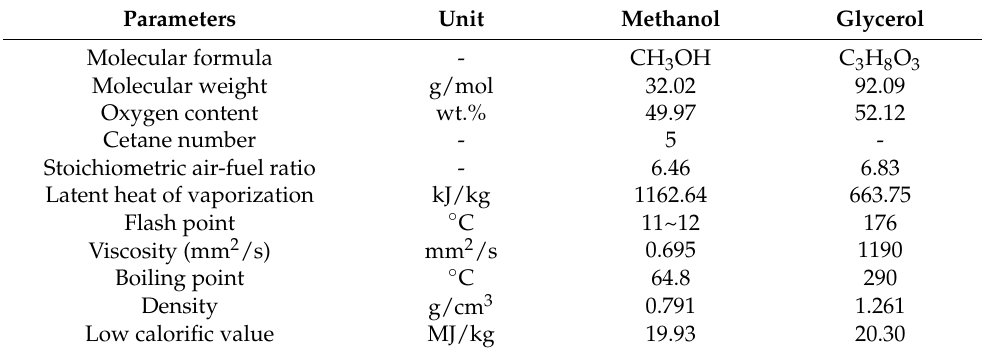
Table 1. Properties of methanol and glycerol [29–32].